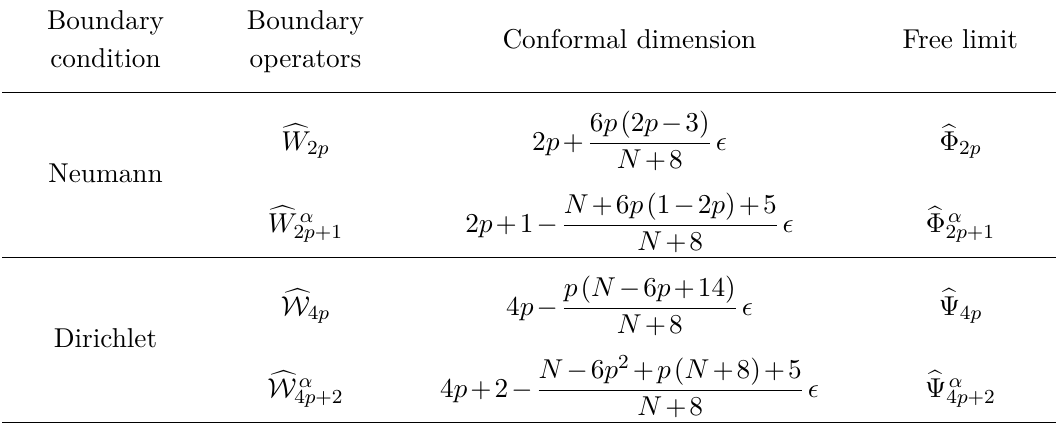
Table 2 . The conformal dimensions of boundary local operators subject to the Neumann and Dirichlet boundary conditions. See appendix A for the notations for the Dirichlet